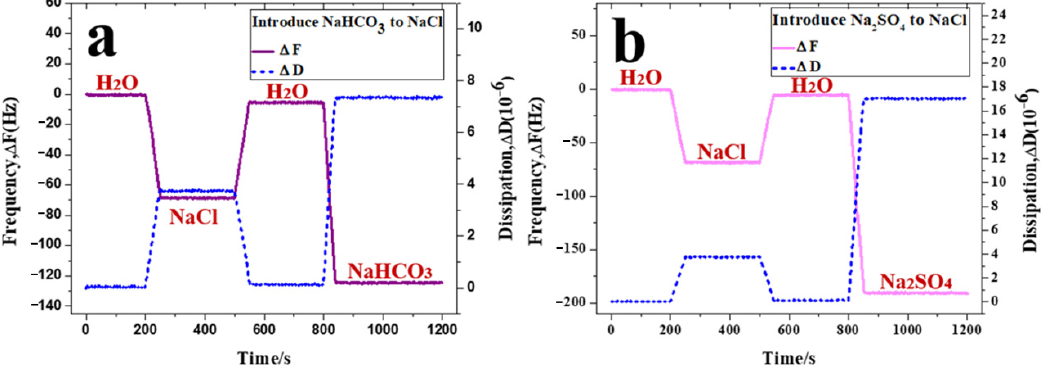
Figure 5. Adsorption behavior of ( a ) NaHCO 3 and ( b ) NaSO 4 , measured using the QCM.